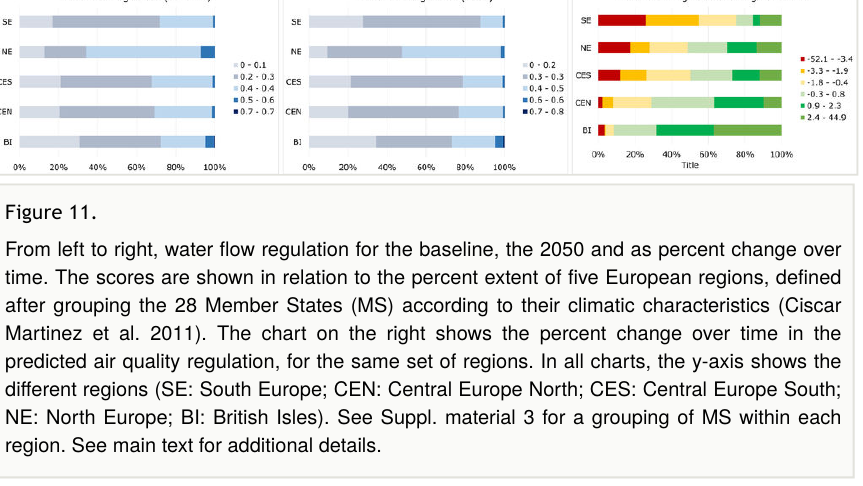
Fig. 11 quanti fi es the distribution of water fl ow regulation scores and relative change over time, across the fi ve European regions. For the baseline, the vast majority of the area within each region was characterised by scores between 0.2 and 0.3, with the exception of North Europe, where the vast majority of the region’s extent scored 0.4. The British Isles and North Europe also recorded noticeable areas within the interval 0.5 – 0.6. The 2050 predictions showed, again for North Europe, the vast majority of the region’s extent within the interval 0.4 – 0.5; whilst areas characterised by the second highest score (0.6) were mainly con fi ned to the British Isles.